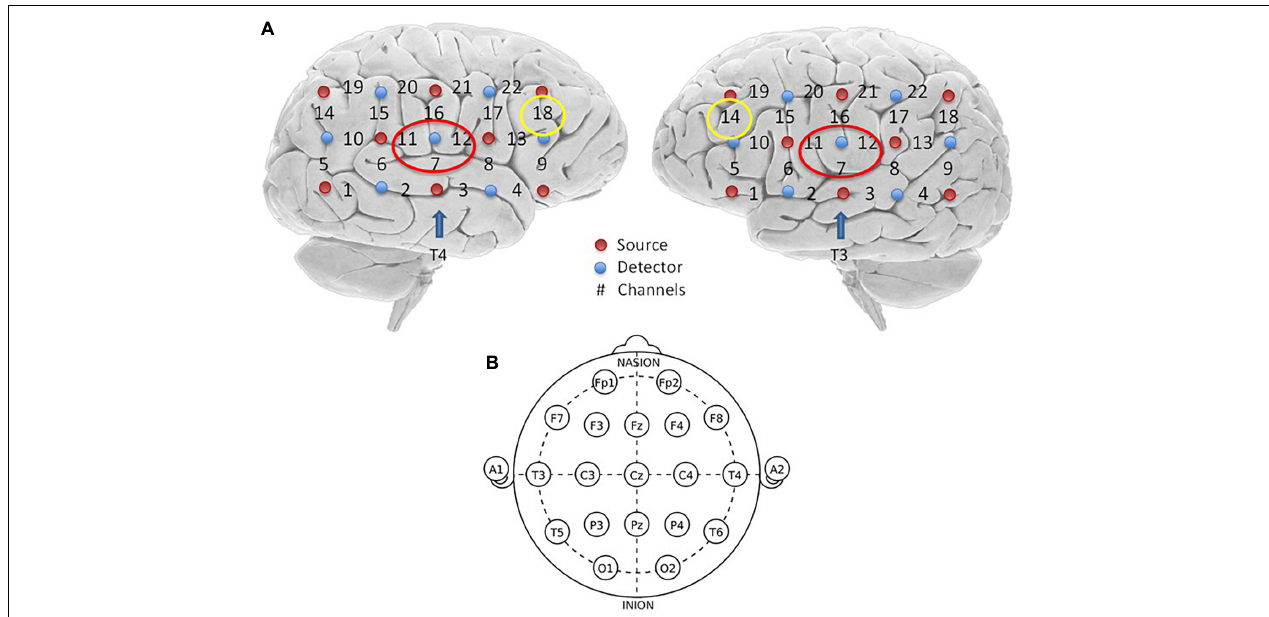
FIGURE 1 | Optode localization and the channel of ROI. (A) Red dots on both hemispheres represent source emitters, blue dots represent detectors, and the numbers represent the channels. There were eight emitters, seven detectors, and 22 channels on each hemisphere. Channels marked with red circles are bilateral channels 7, 11, and 12, which are the interest regions of the superior temporal sulcus selected in this study. Channels marked with yellow circles are channel 18 on the left and channel 14 on the right, which are the interest regions of BA46 selected in this study. (B) Two arrays of probes were placed in the left and right temporal regions, respectively, and placed on each subject’s head, according to the relevant standard position of the International 10–20 System (Obrig and Villringer, 2016). The upper channel was placed horizontally at T3/T4 and vertically at C3/C4.